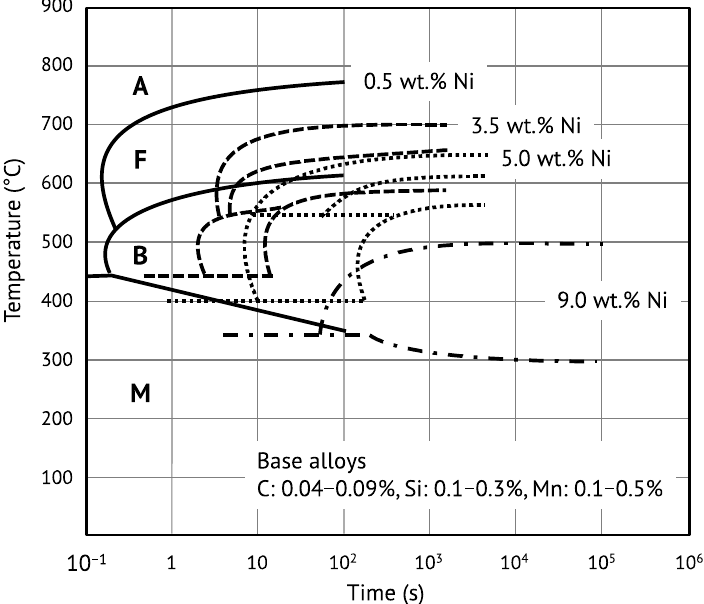
Figure 3. CCT diagrams (austenitizing at 800–900 ◦ C) demonstrating the effect of Ni on the transformation behavior of low-carbon structural steels (Reprint from Ref. [19]).